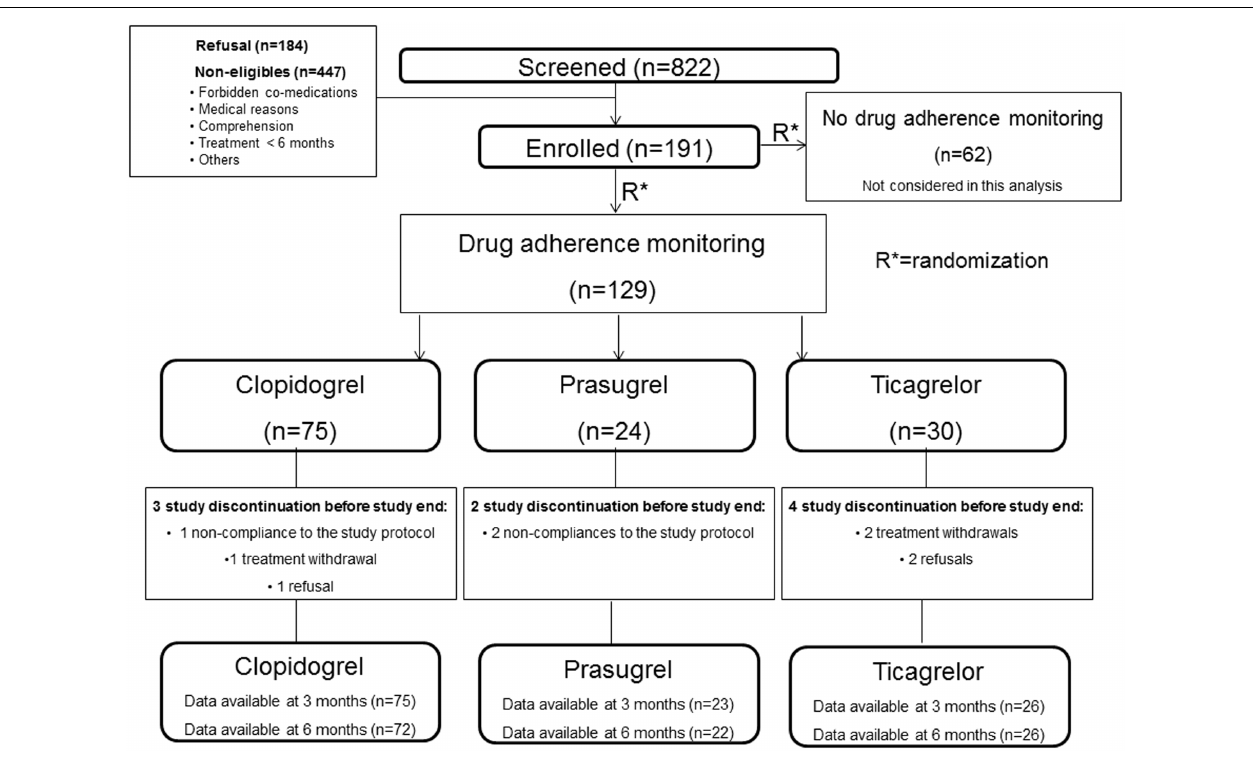
FIGURE 1 | Flow diagram of the